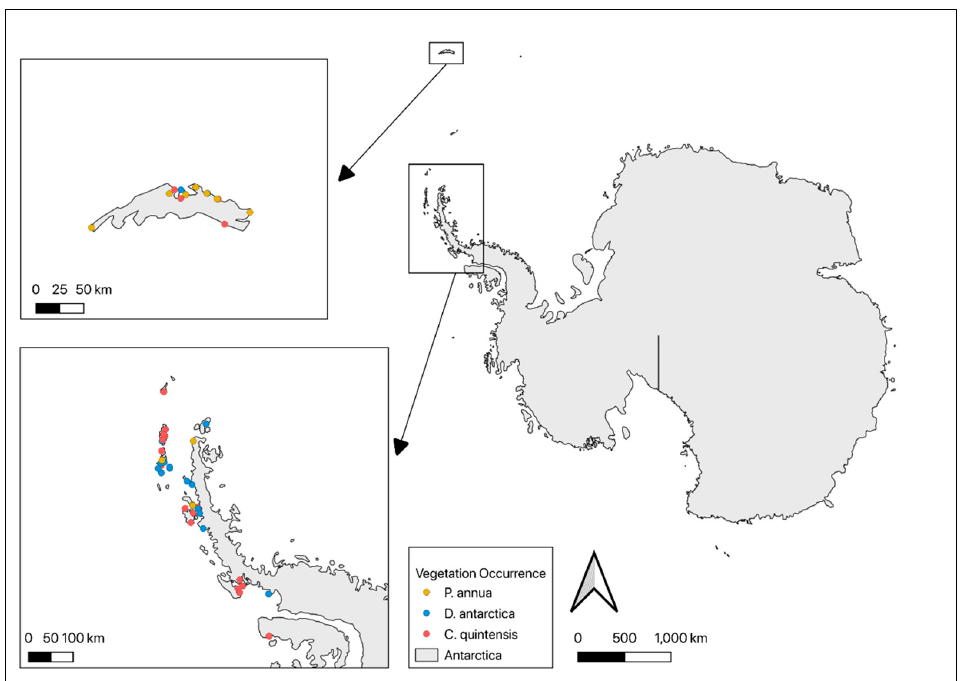
Figure 2. Vegetation Occurrence Points of D. antarctica, C. quitensis and P. annua .